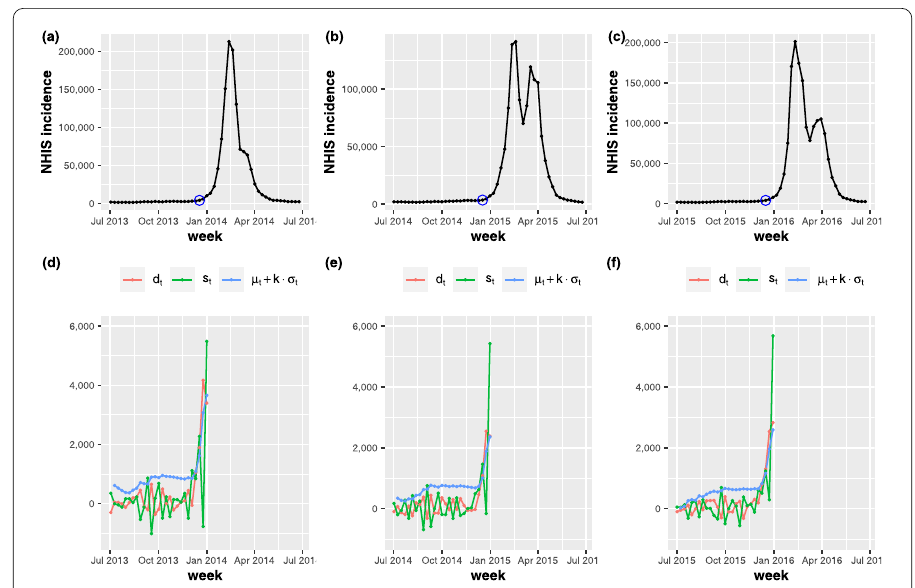
Figure 2 The time derivative of influenza incidence. Fig. 2( a )–( c ) show the total number of new patients within a week for three influenza seasons (2013–14, 2014–15, 2015–16). In Fig. 2( d )–( f ), d t , s t , μ t , and σ t represent the first derivative, second derivative, seasonal cumulative mean and standard deviation, respectively. We confirm that d t abruptly fluctuates around zero before the onset of influenza outbreak. Then, the difference between d t and μ t increases at the onset of influenza outbreak. In Fig. 2( a )–( c ), the onset week t where the condition (2) is satisfied is marked by the blue circle